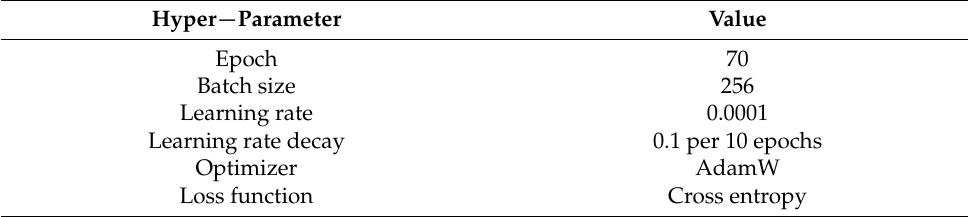
Table 2. Training